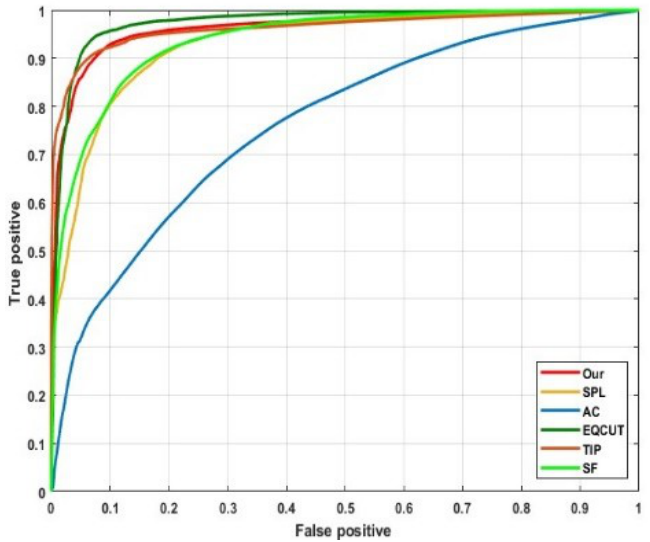
Figure 11. Precision-recall (PR) curves comparing the proposed approach with existing ones. Our algorithm outperforms the others, except TIP.